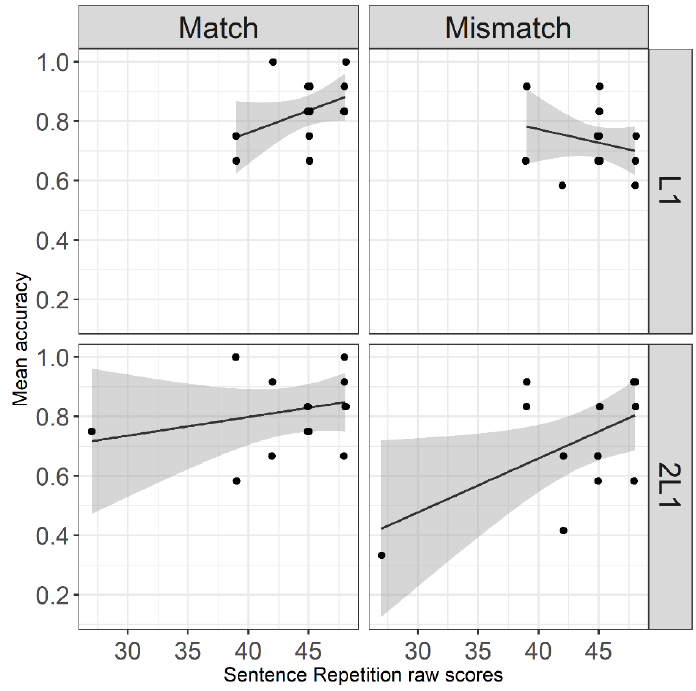
Figure 3. Scatterplot of the accuracy scores with the scores in the sentence repetition test.